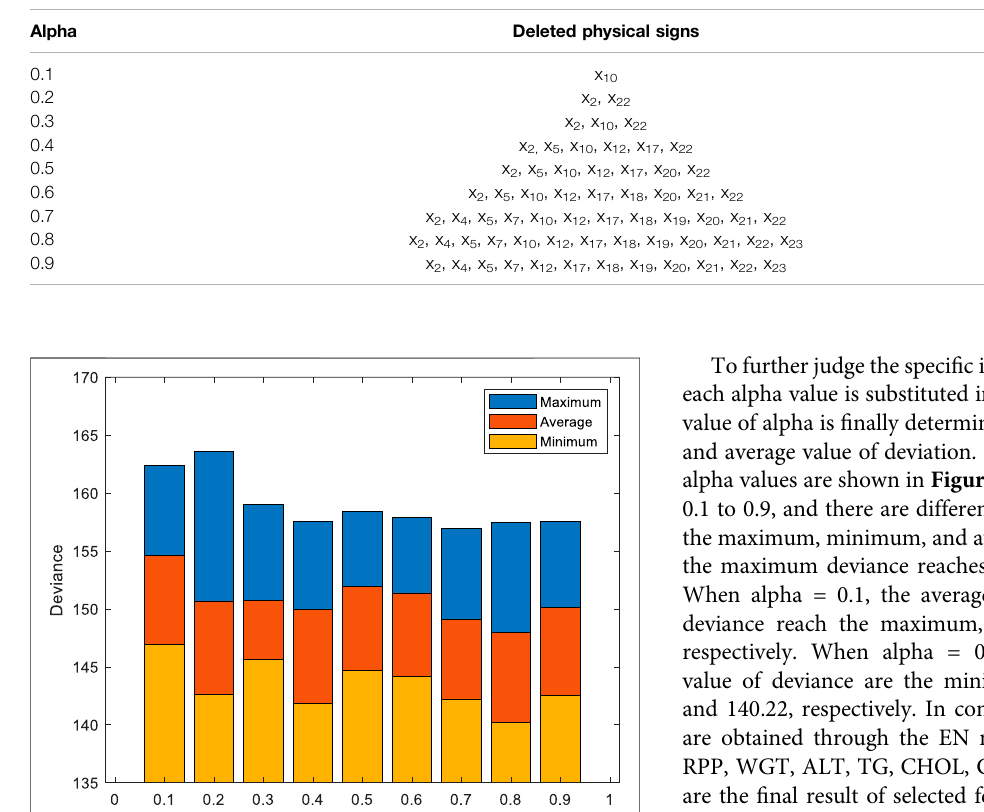
TABLE 2 | Results of physical sign screening.